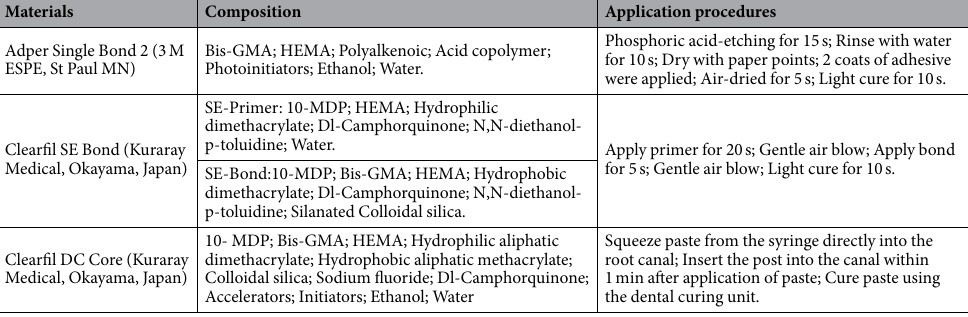
Table 4. Adhesives and cement used in this study. Bis-GMA: bisphenol-A diglycidyl ether dimethacrylate; HEMA: 2-hydroxyethyl methacrylate; MDP: 10-methacryloyloxydecyl dihydrogen